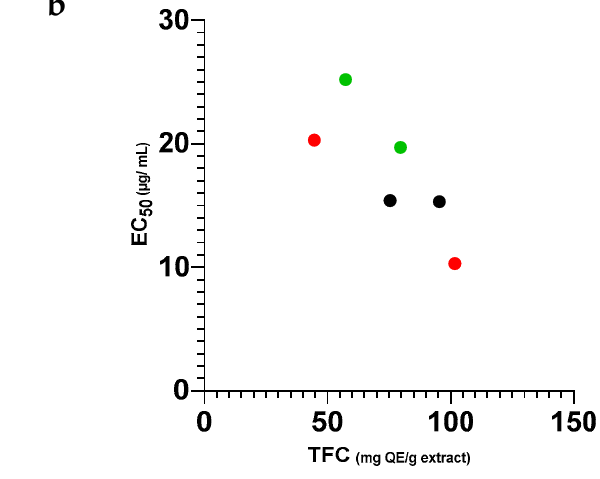
Figure 2. Correlation between antioxidant potential (EC 50 values) and TPC ( a ) and TFC ( b ) of indi- vidual ethanol extracts of propolis from Pereiro ( ) and from Gerês ( ) and of propolis blends (mP + G) ( ).